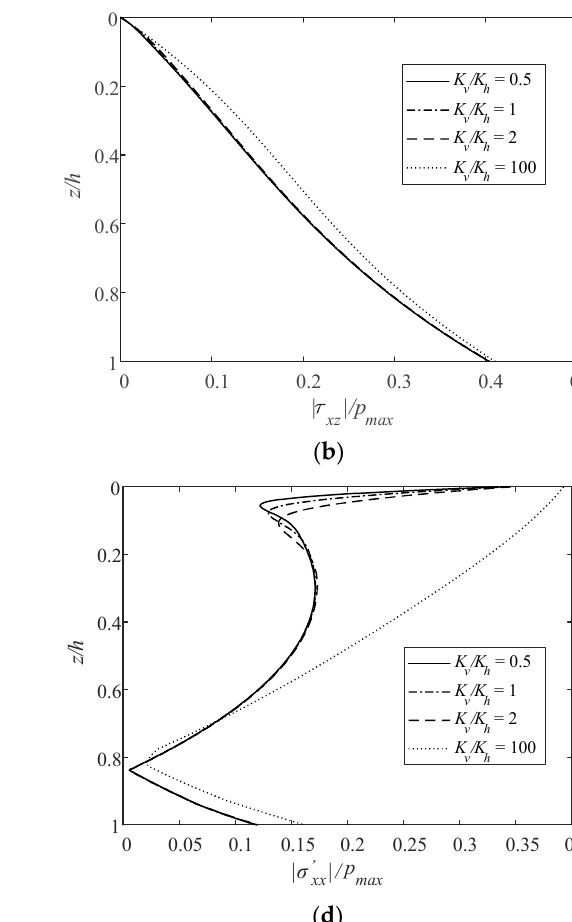
Figure 9. Vertical distributions of normalized maximum ( a ) pore pressure, ( b ) shear stress, ( c ) ver- tical effective stress, and ( d ) horizontal effective stress by varying K v / K h .